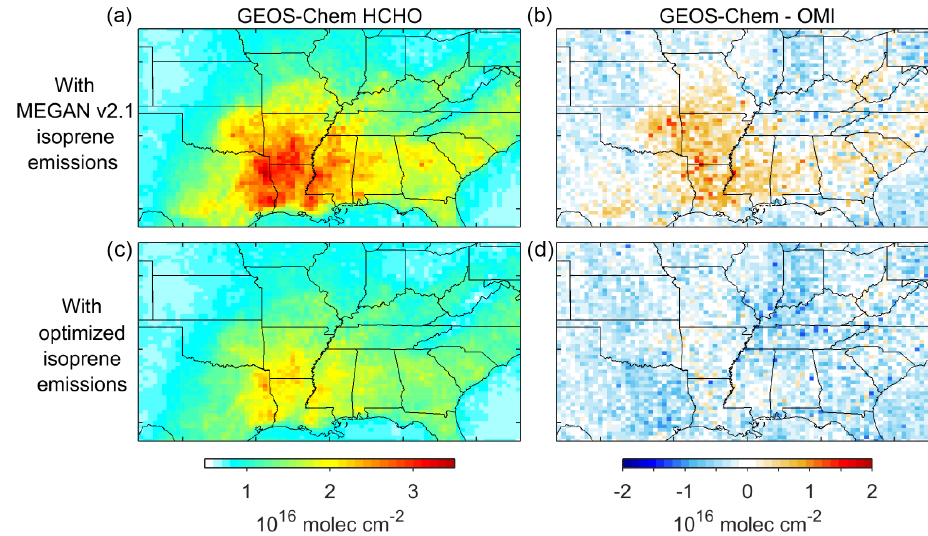
Figure 4. Simulated HCHO vertical column densities and model bias using prior and optimized isoprene emissions. Values are averages for 1 August – 25 September 2013 at the OMI overpass time (13:30LT), weighted by the OMI measurement error as in Fig. 1. (b) and (d) show the differences between the simulated columns and the OMI observations from Fig. 1.